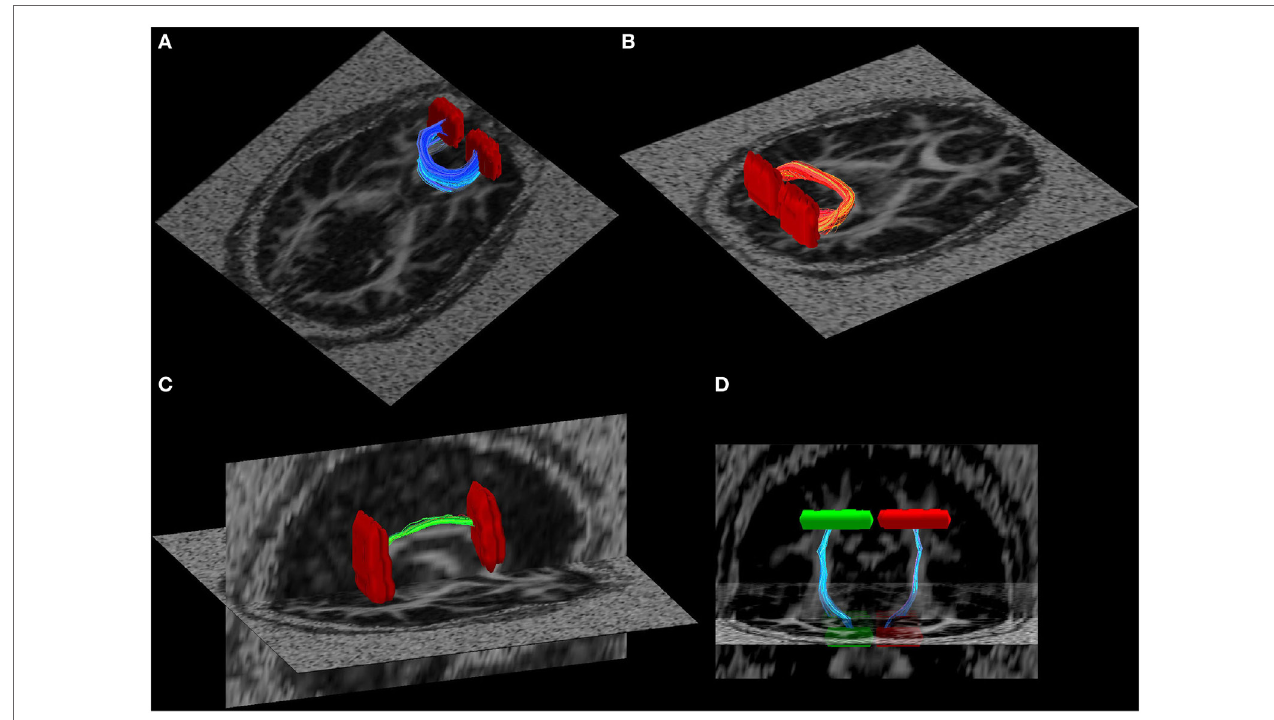
FigUre 1 | illustration of some of the white matter tracts used in the tract-based fractional anisotropy quantification . (a) Forceps major, (B) forceps minor, (c) R-cingulum, and (D) cortical spinal tract. Seed regions of interest are illustrated in red and